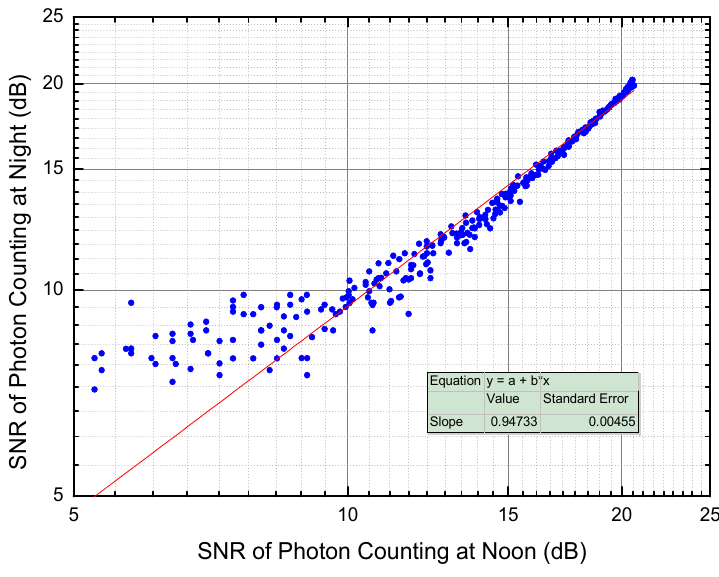
Figure 9. SNR comparison between day and night